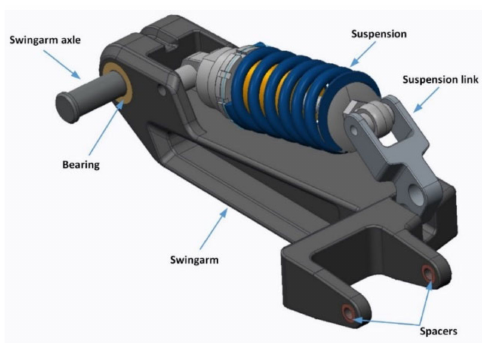
Figure 3. Front swingarm initial design.